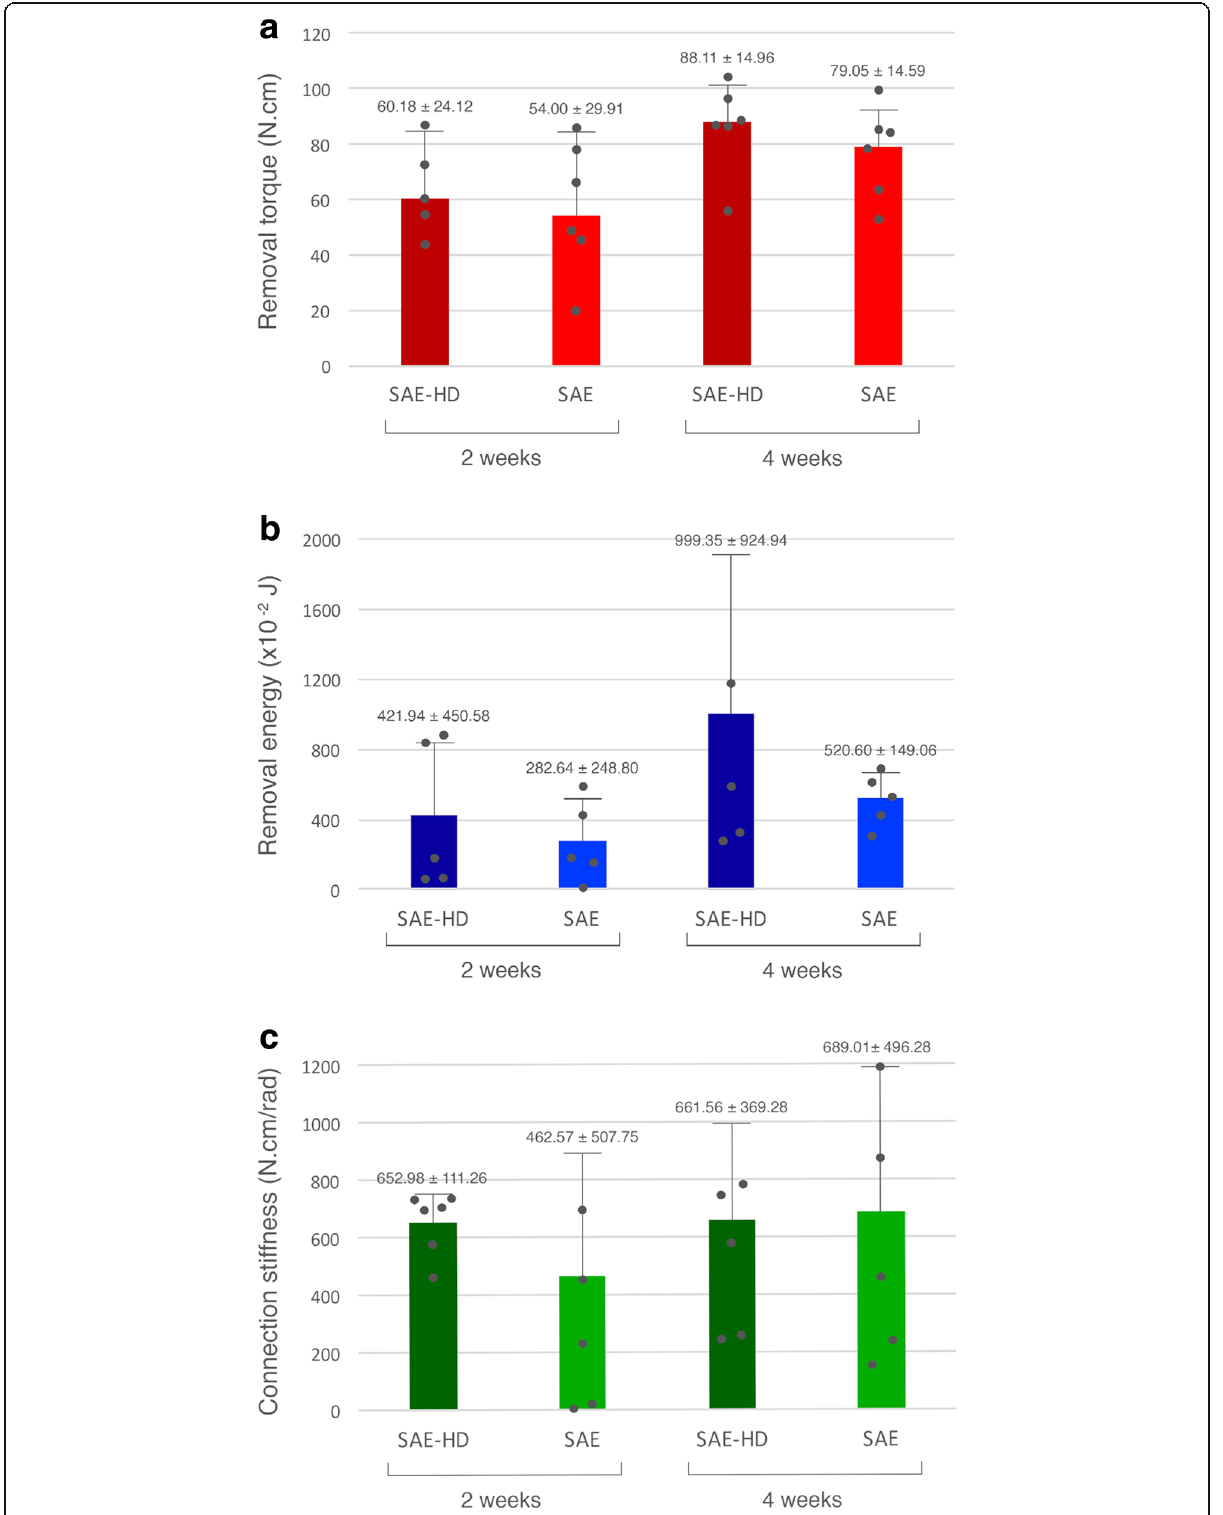
Fig. 5 Mean and standard deviation of the biomechanical data at both observation periods ( P > 0.05). a Removal torque. b Removal energy. c Connection